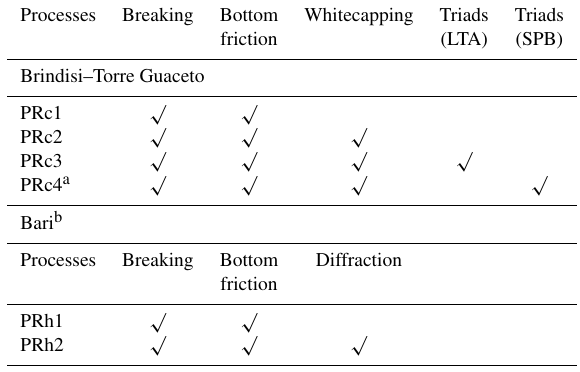
Table 2. Definition of the processes included in TELEMAC and MIKE21 spectral wave models’ set-up (see Table